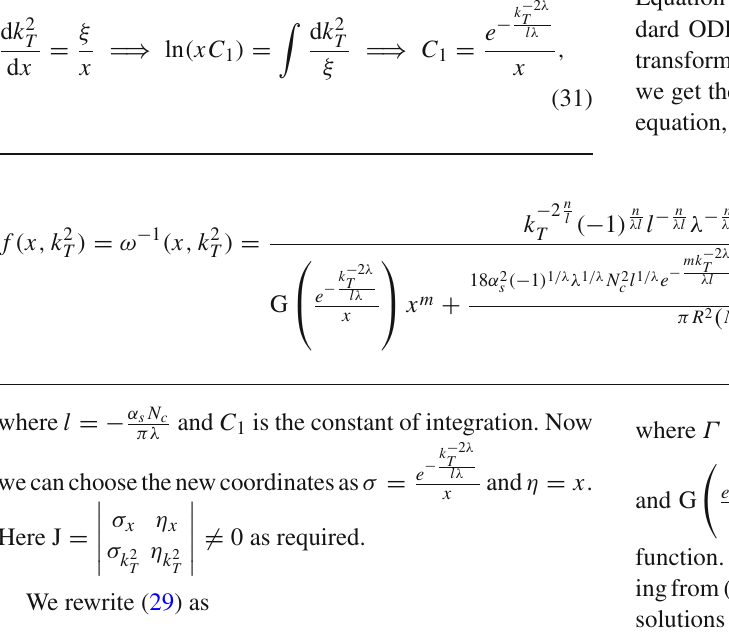
ζ (greendottedline)and (cid:13) + 2 λ − 1 k 2 λ T s N c